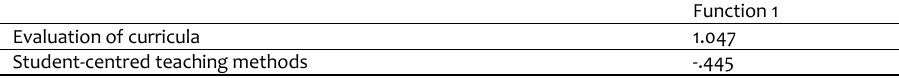
Table 6: Standardized canonical discriminant function